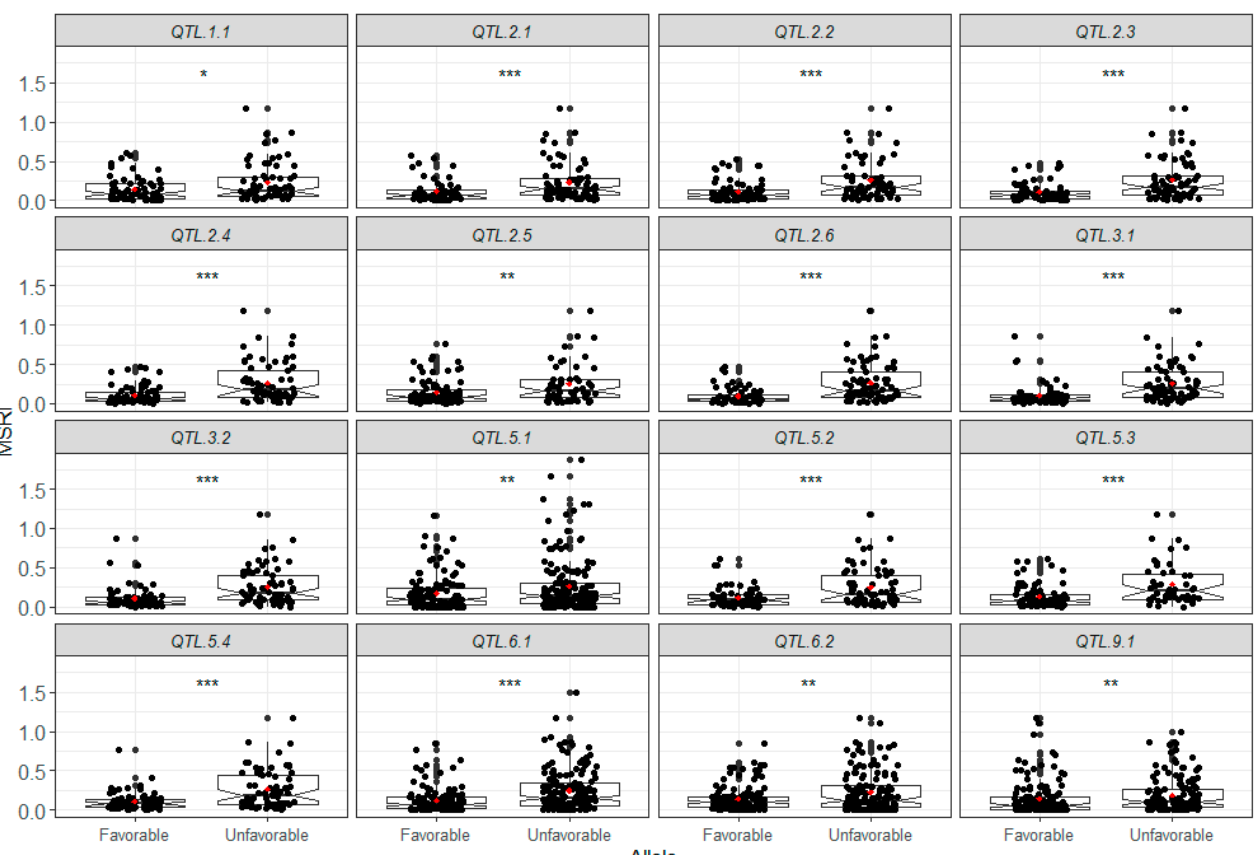
Figure 2. Box plots of 16 quantitative trait loci (QTL) associated with marsh spot resistance index (MSRI). *: p < 0.05; **: p < 0.01; ***: p < 0.0001. In each box plot, the black dots represent data points and the red dot represents the mean of the data points.